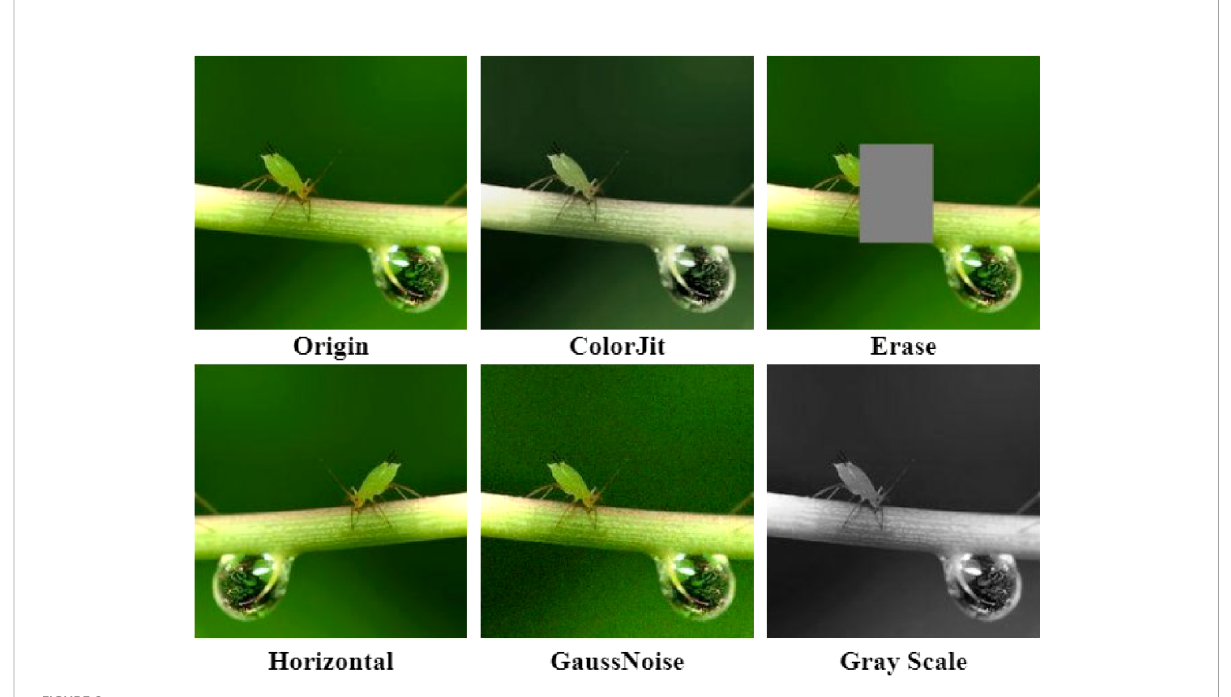
FIGURE 2 Data-augmentation operations of the original